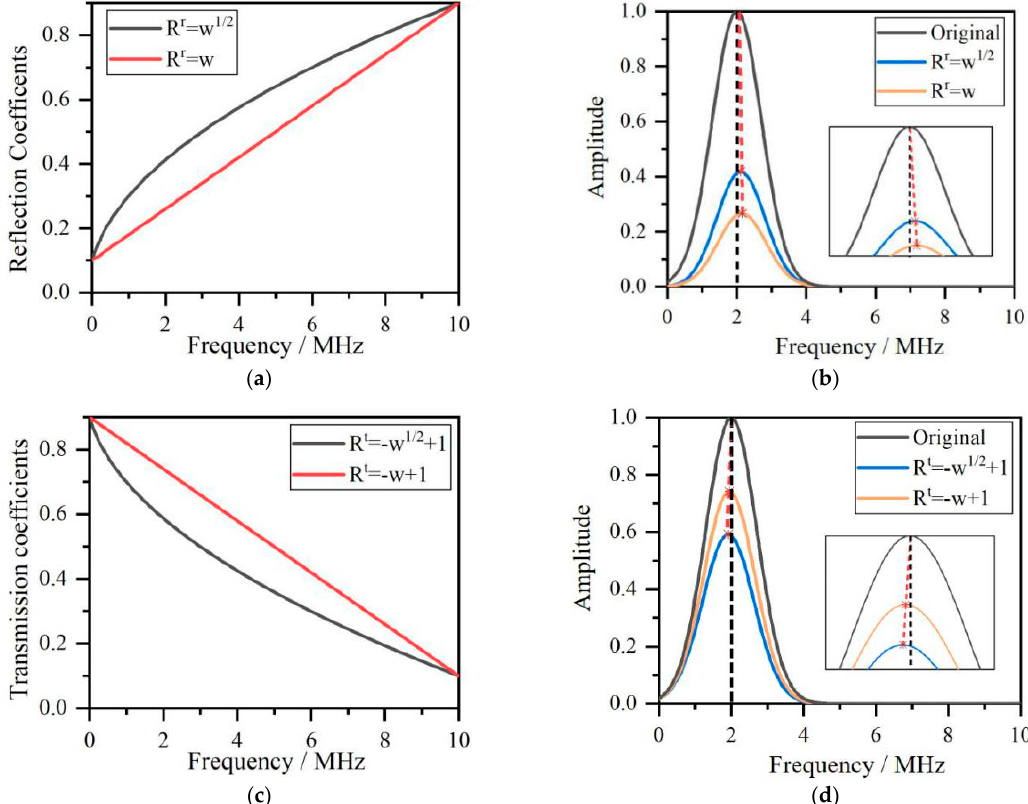
Figure 2. ( a ) Reflection coefficients functions. ( b ) Frequency spectrum of reflection Rayleigh wave. ( c ) Transmission coefficients functions. ( d ) Frequency spectrum of transmission Rayleigh wave.